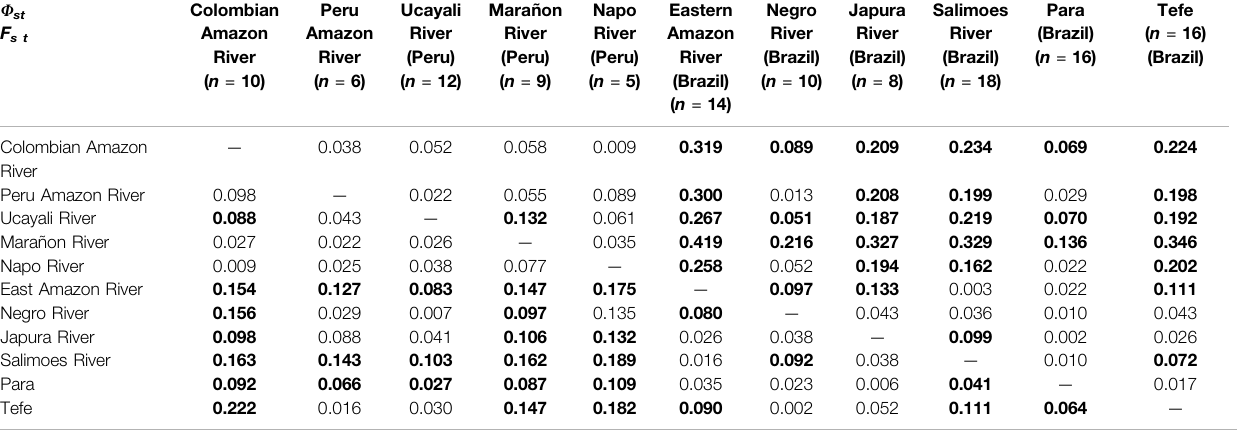
TABLE 2 | Pairwise Fst (below diagonal) and Φ st (above diagonal) values for the mitochondrial control region (361 bp) among 11 T.inunguis geographic locations. Φ st F s t